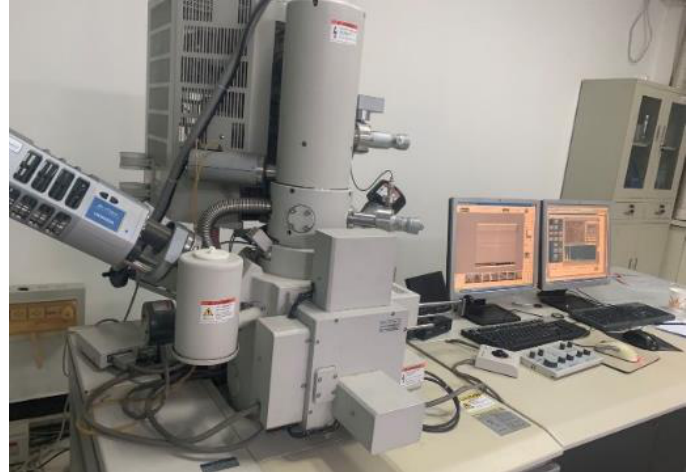
Figure 3. S-4800 scanning electron